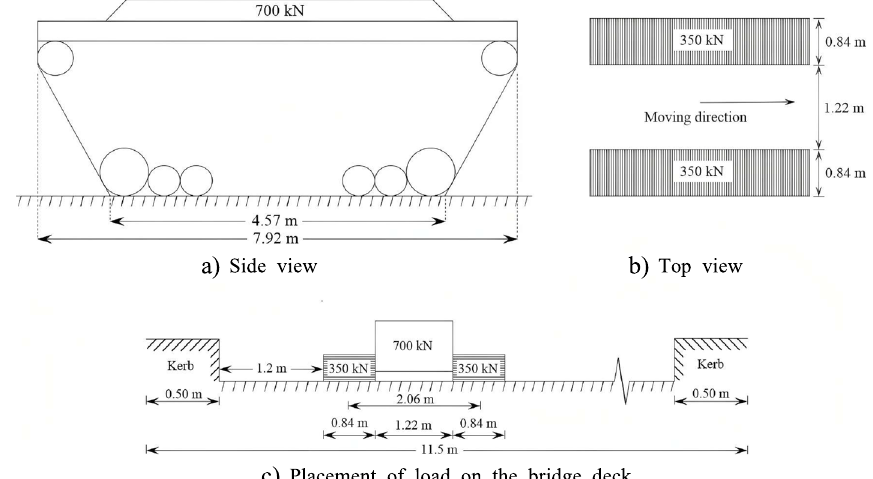
Fig. 6 IRC Class-70R track load. a Side view. b Top view. c Placement of load on the bridge deck